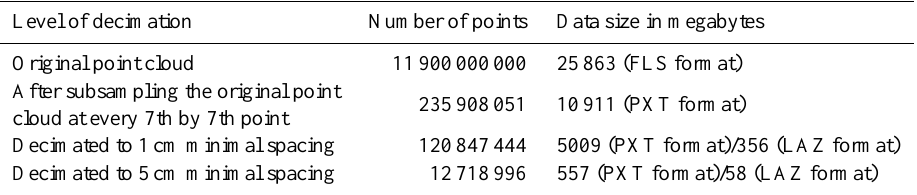
Table 1. Summary of point cloud